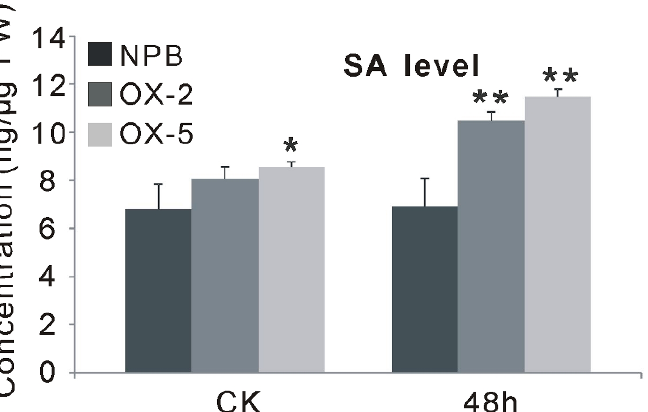
Figure 6. The SA levels of the OXGF14f and wild-type plants before and after blast infection. * p < 0.05, ** p < 0.01.